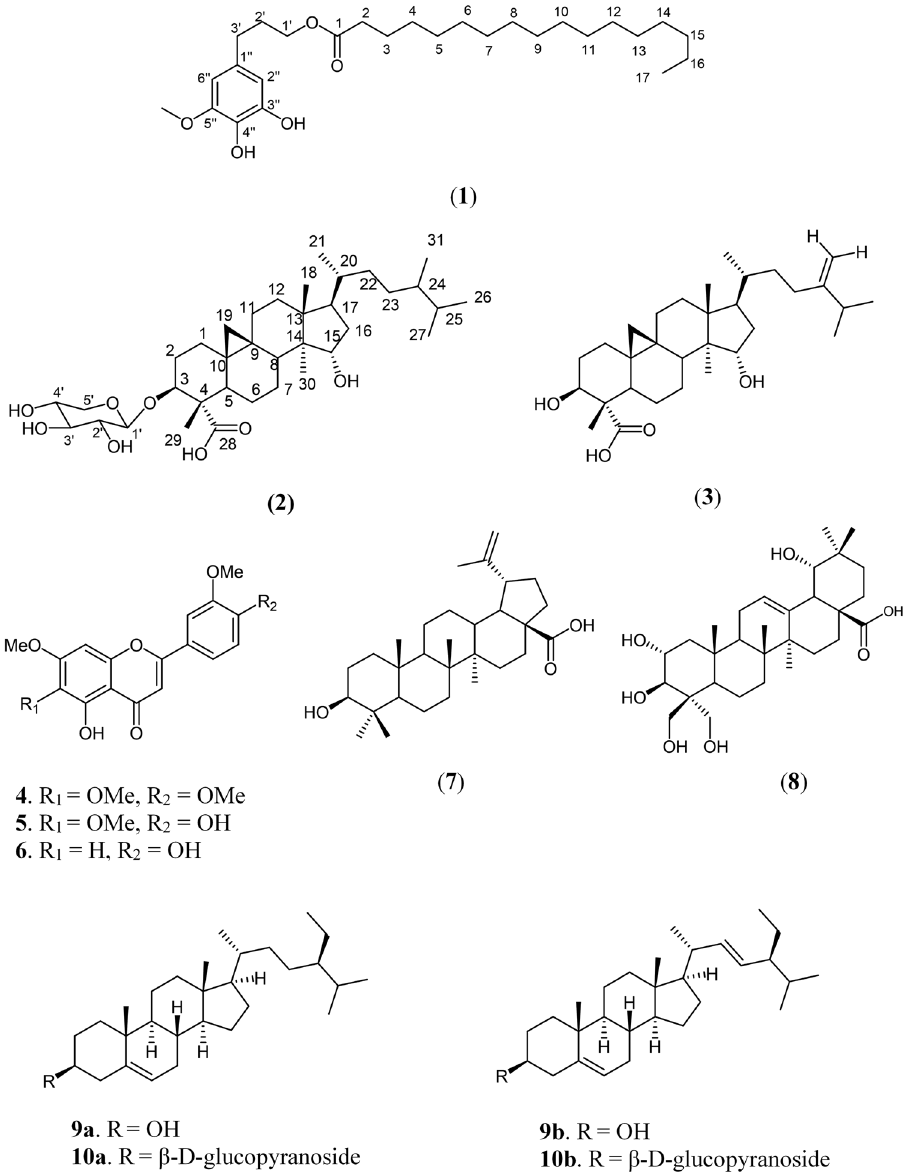
Figure 1: Chemical structures of compounds isolated from Combretum fragrans F. Ho ff